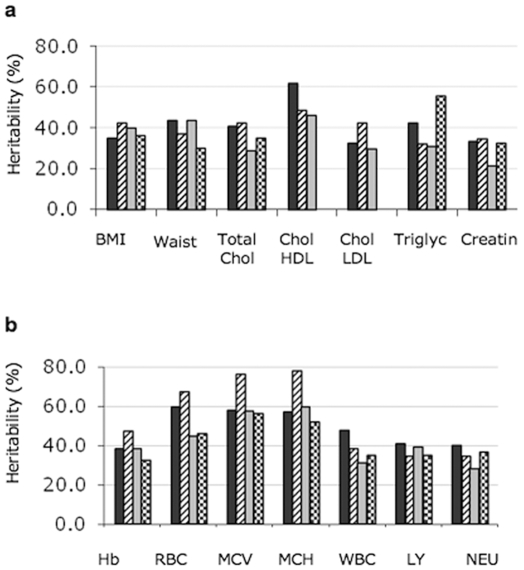
Comparison of the heritability of different genetic isolates from Italy.a. anthropometric and lipid measures. B: blood measures. The traits are indicated along the X-axis. Black bar: Val Borbera; dashed bar: Lanusei; grey bar: Cilento; checkered bars: Carlantino. Abbreviations are as in table 1 and 2.